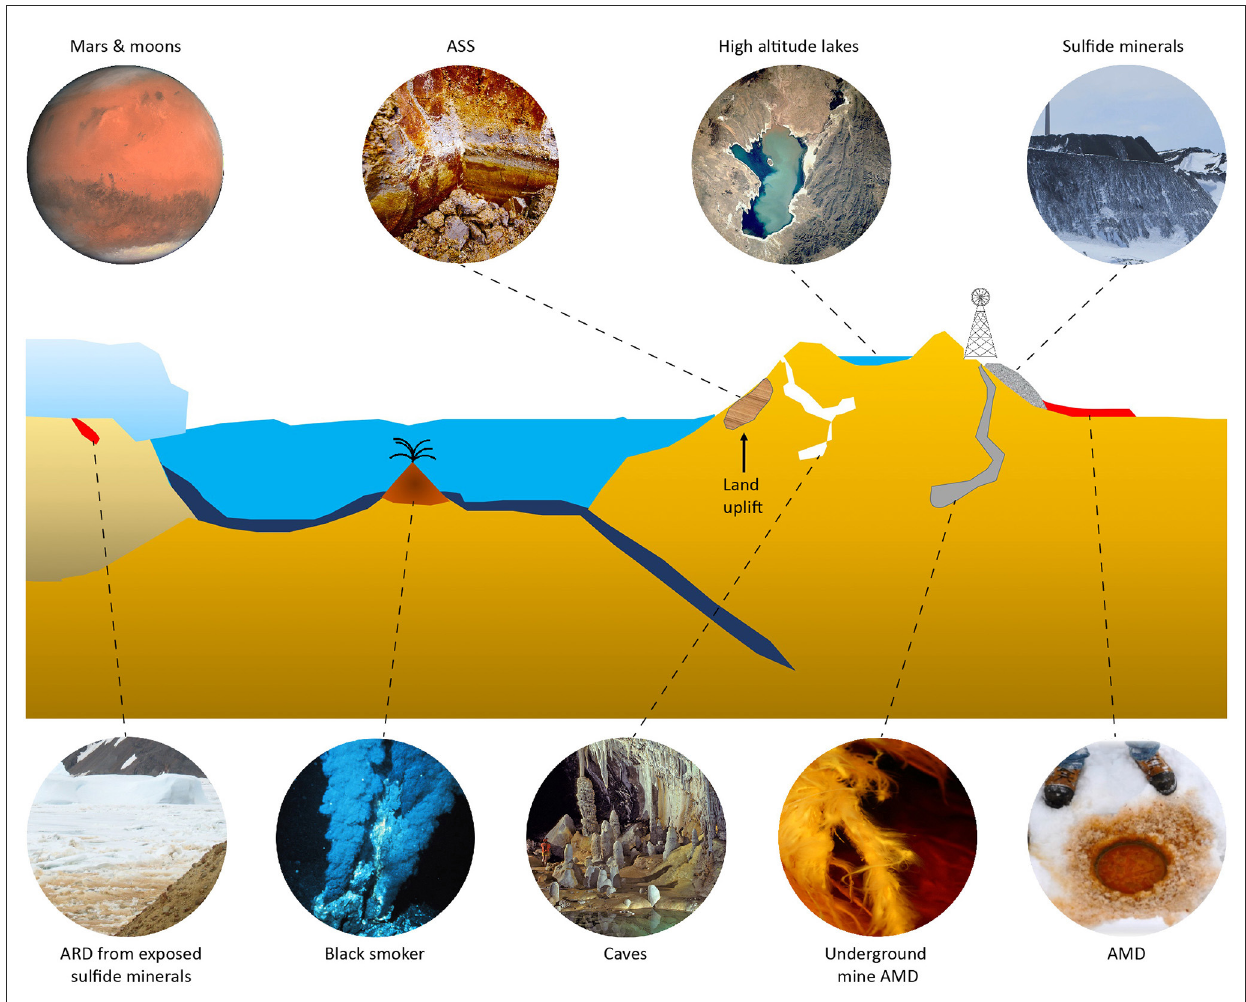
FIGURE1 Acidic and low-temperature environments. Clockwise from top left: Mars and moons of Saturn and Jupiter (modified from Wikipedia CC BY-SA 3.0 IGO); boreal AS soil (ASS) created by land uplift (courtesy Eva Högfors-Rönnholm); high altitude lake (modified from Wikipedia public domain image); mining of metal sulfides at, e.g., high altitudes; AMD from under ice sulfide tailings seepage ponds; a low-temperature AMD stream in an underground mine; low-temperature caves (modified photograph by Dave Bunnell from Wikipedia CC BY-SA 2.5); black smokers releasing sulfides (modified from Wikipedia public domain image); and ARD from sulfide minerals, e.g., Antarctica (credit Ángeles Aguilera, Bernhard Dold, and Elena González-Toril), reproduced with